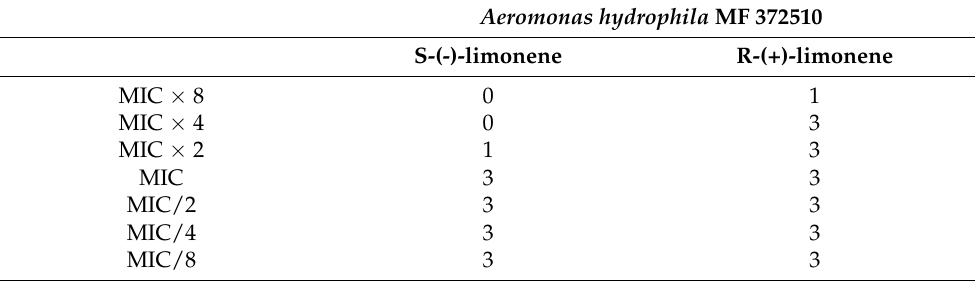
Table 3. Effects of phytochemicals S-(+)-limonene and R-(+)-limonene on the biofilm formation of Aeromonas hydrophila isolated from fish (MF